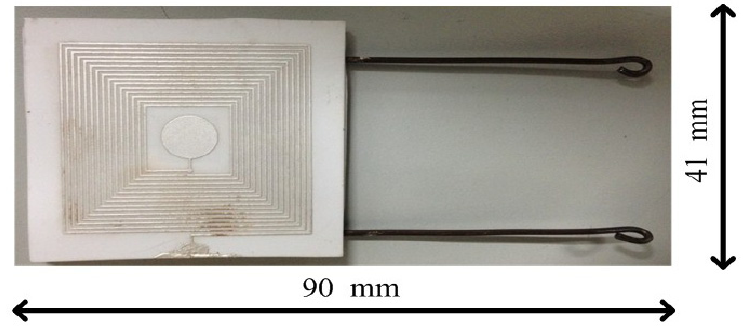
Figure 5. Photograph of the LC capacitance pressure sensor.